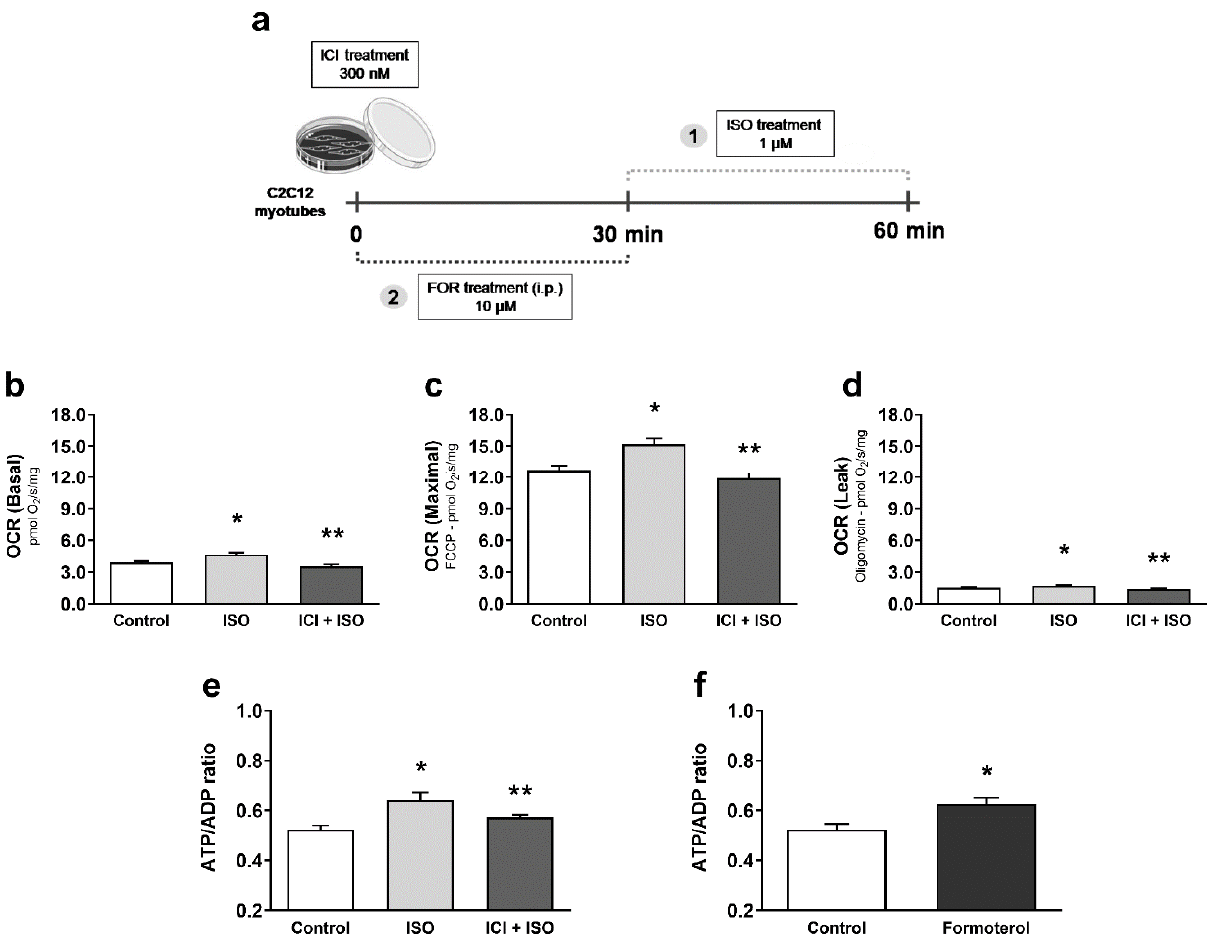
Figure 7. Pharmacological activation of β 2 -AR receptors leads to increased mitochondrial function and ATP production in C2C12 myotubes. Experimental design for pharmacological treatments in C2C12 myotubes ( a ), basal mitochondrial OCR (oxygen consumption ratio) ( b ), maximal mitochondrial OCR induced by FCCP ( c ), ATP-independent OCR measured in the presence of oligomycin ( d ), and ATP production ( e ) in C2C12 myotubes acutely exposed to the non-selective β -AR agonist isoproterenol (ISO—1 µ M for 30 min), with or without β 2 -AR receptor blockade with ICI 118,551 (300 nM, 30 min prior to ISO treatment). ATP production ( f ) in C2C12 myotubes acutely exposed to the selective β 2 -AR agonist formoterol (10 µ M for 30 min). Data are presented as mean ± SE. * p < 0.05 vs. control and ** p < 0.05 vs. ISO. n = 8/group.